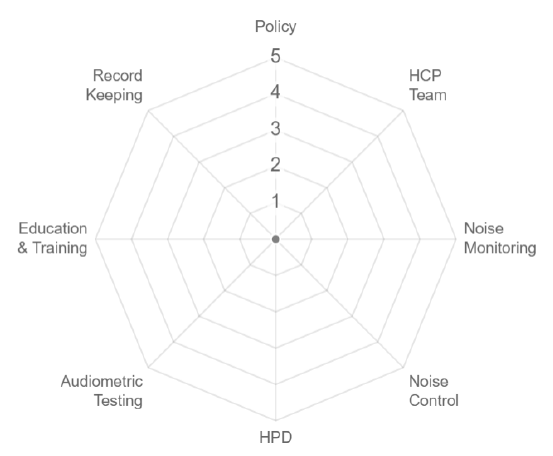
Figure 1. Octa-Hearing Conservation Index (OHCI) Figure 1. Octa ‐ Hearing Conservation Index (OHCI) system.